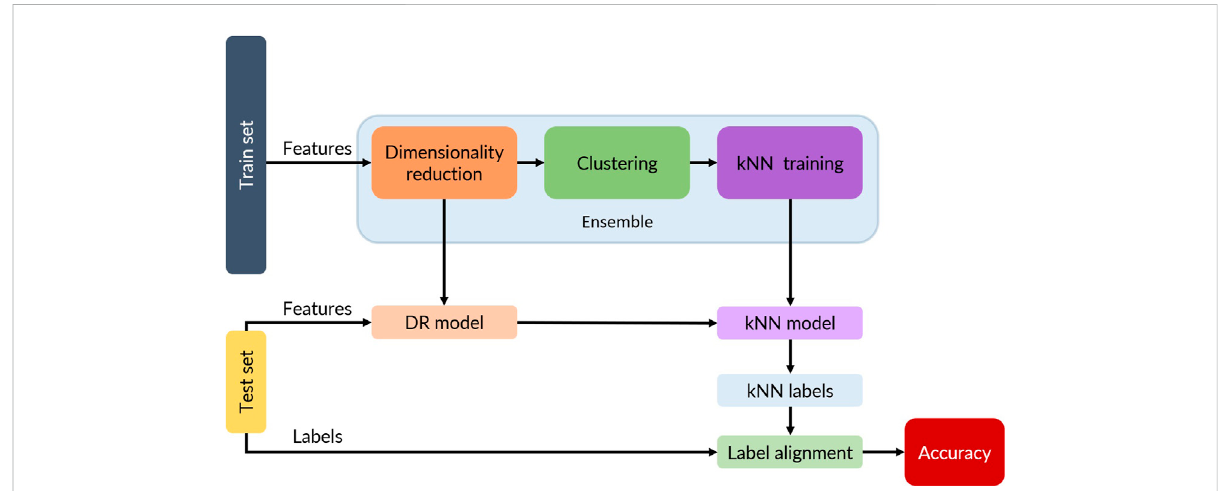
FIGURE 1 Flow diagram for the training and testing data. Features from the train set are reduced and clustered to generate labels (unsupervised learning). TheresultinglabelsarethenusedtotrainakNNmodelandaninternalaccuracy(kNNaccuracy)iscomputed.ThedimensionalityreductionandkNN models are used to predict labels from the test set ’ s features and a real accuracy is computed by comparing the kNN labels with the ground truth labels (testing set labels).